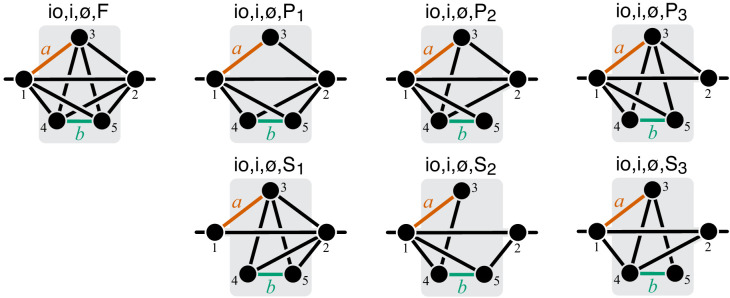
Graphical representation of strictly serial and strictly parallel generating topologies in class Mio,i,∅.Fully connected topology io,i,∅,F is shown for reference (same as in Figure 8).